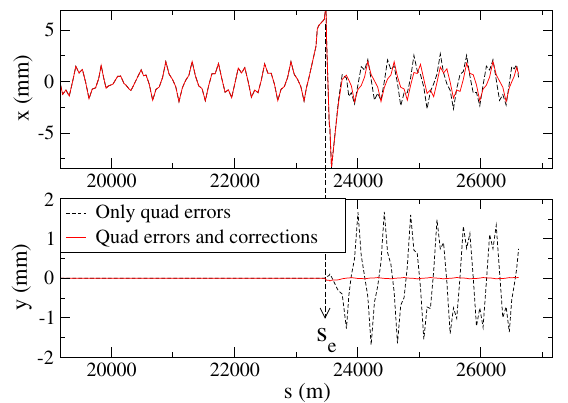
FIG. 6. This first turn trajectory shows how betatron oscilla- tions are fed into the y plane due to the skew quadrupole errors placed in IR1 (black). Corrections of Table I reduce significantly the induced trajectory in the y plane (red), which indicates a good local compensation of linear coupling at IR1.